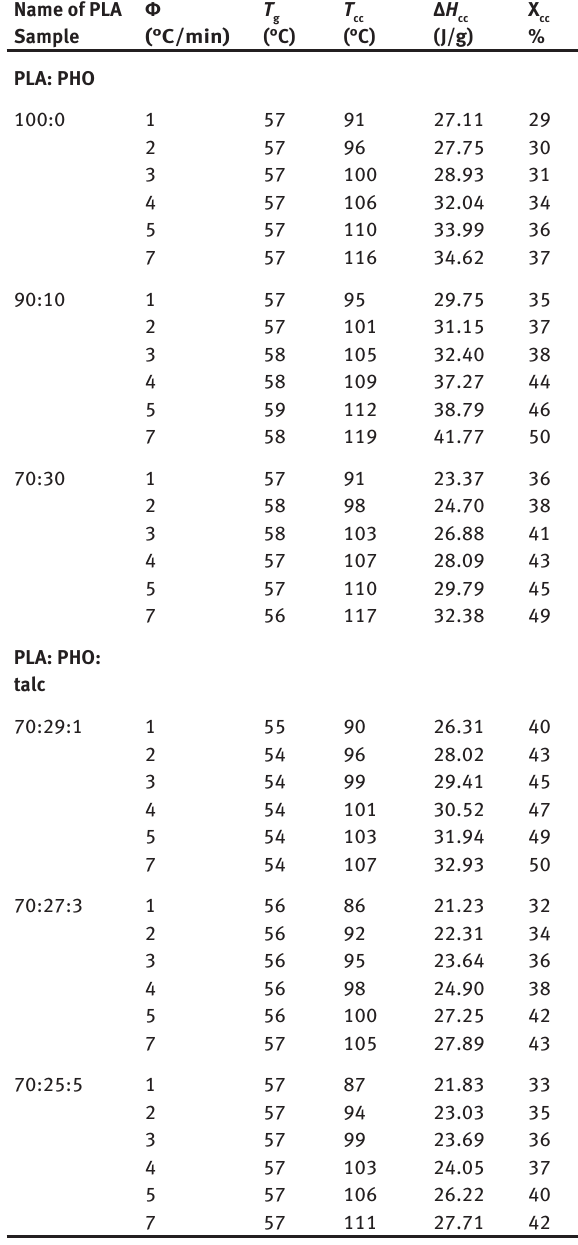
Table 2: Characteristic data of nonisothermal cold crystallization for neat PLA and its